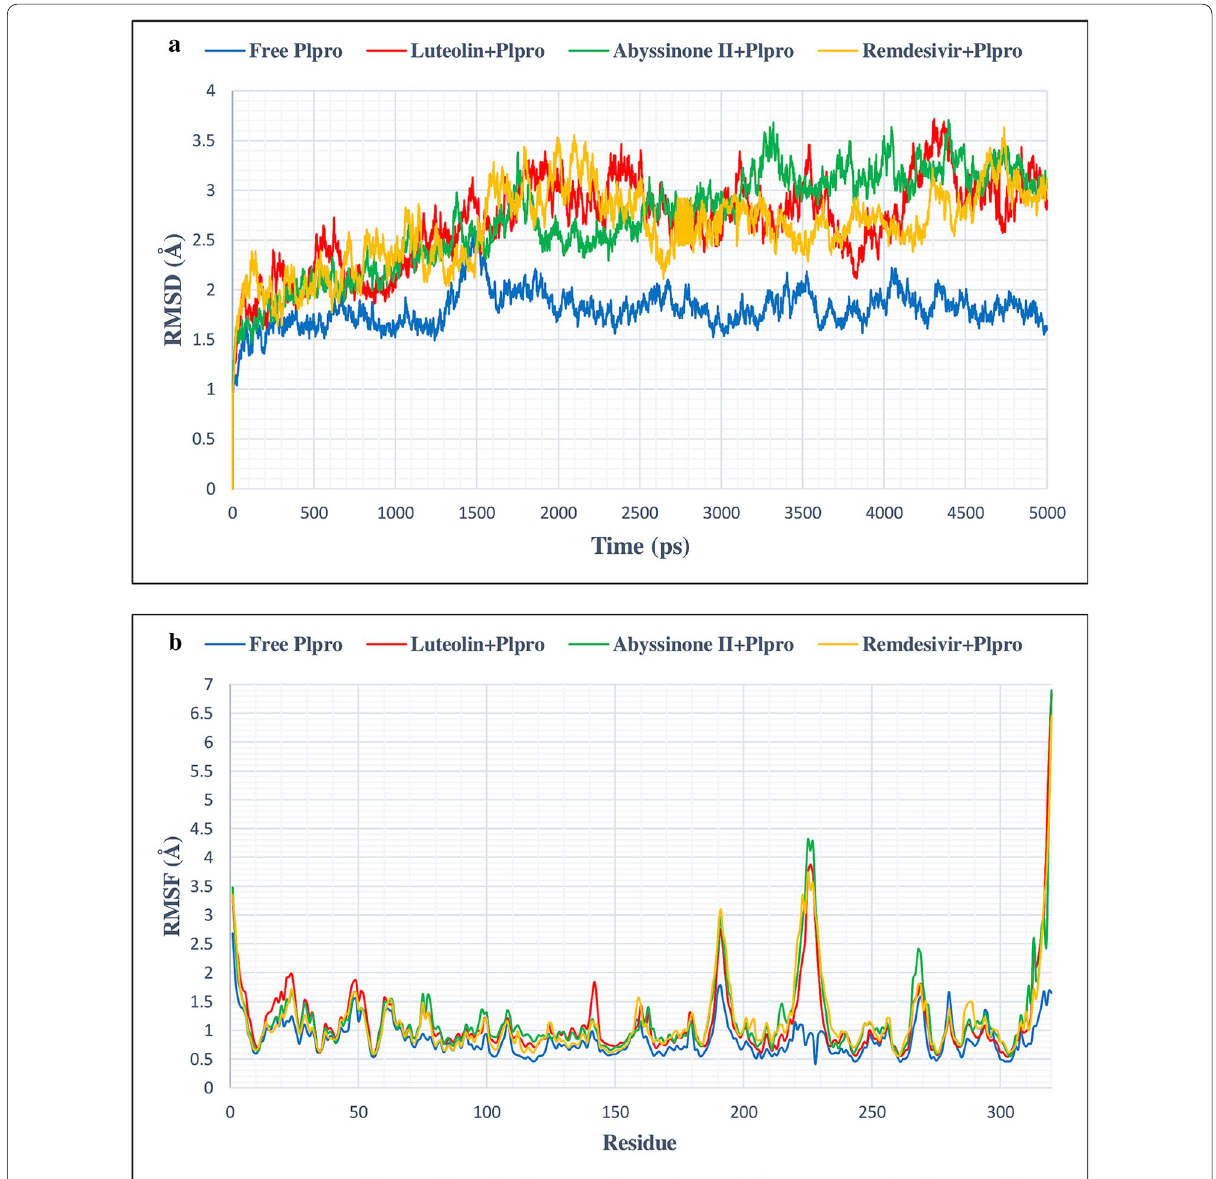
Fig. 7 a RMSD plot of 5 ns MD simulation for free and bound PLpro complexed with C3/luteolin, C43/abyssinone II and Con-2/remdesivir, b RMSF plot of free and bound PLpro complexed with C3/luteolin, C43/abyssinone II and